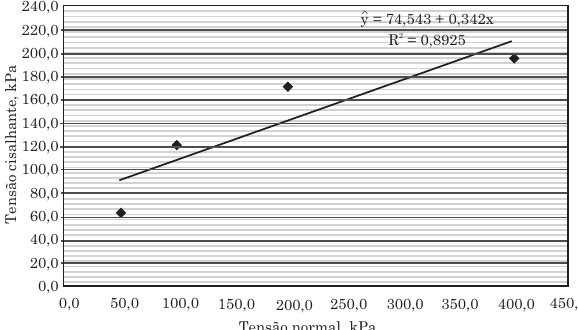
Figura 6. Envoltória de ruptura do talude com sete anos de plantio do capim vetiver.